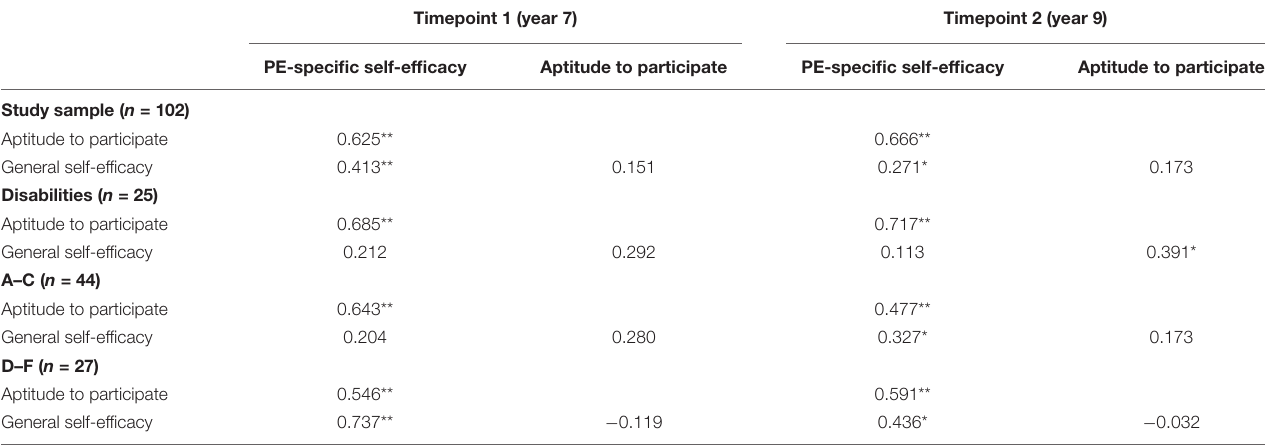
TABLE 3 | Partial correlations between self-efficacy (PE-specific and general) and aptitude to participate at T1 and T2, controlling for the third